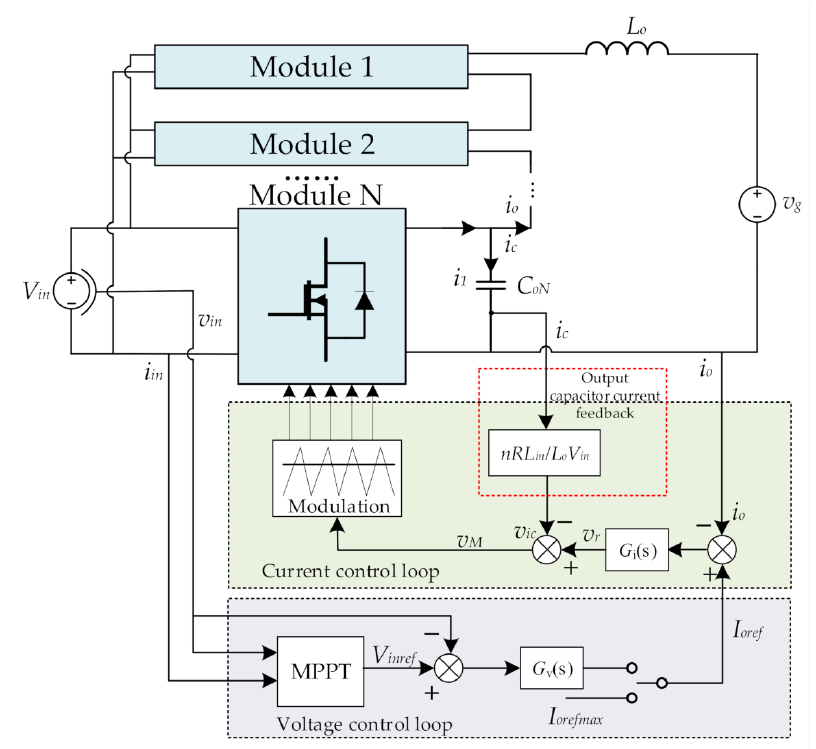
Figure 17. Complete control scheme of the